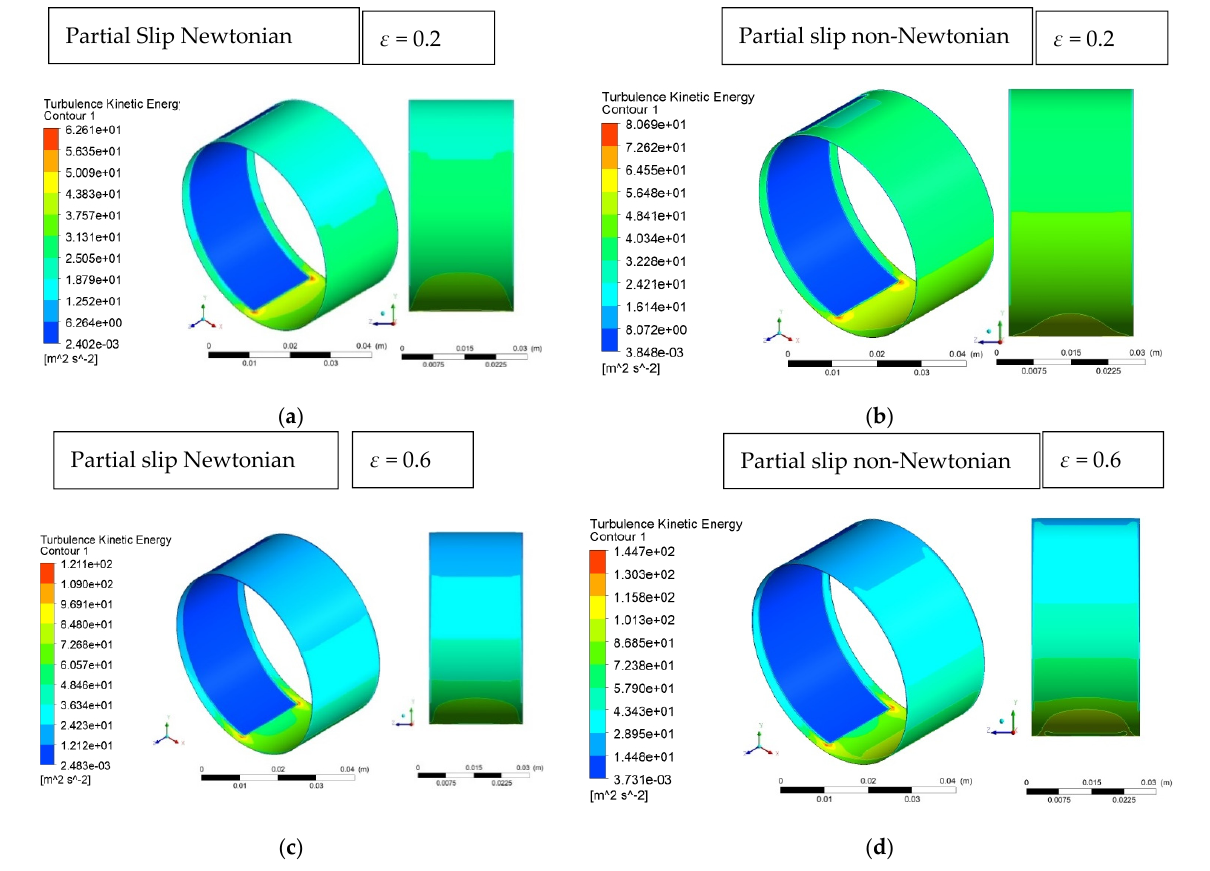
Figure 14. Turbulence kinetic energy for partial slip bearing for case: ( a ) Newtonian, ε = 0.2; ( b ) non- Newtonian, ε = 0.2; ( c ) Newtonian, ε = 0.6; ( d ) non-Newtonian, ε = 0.6.